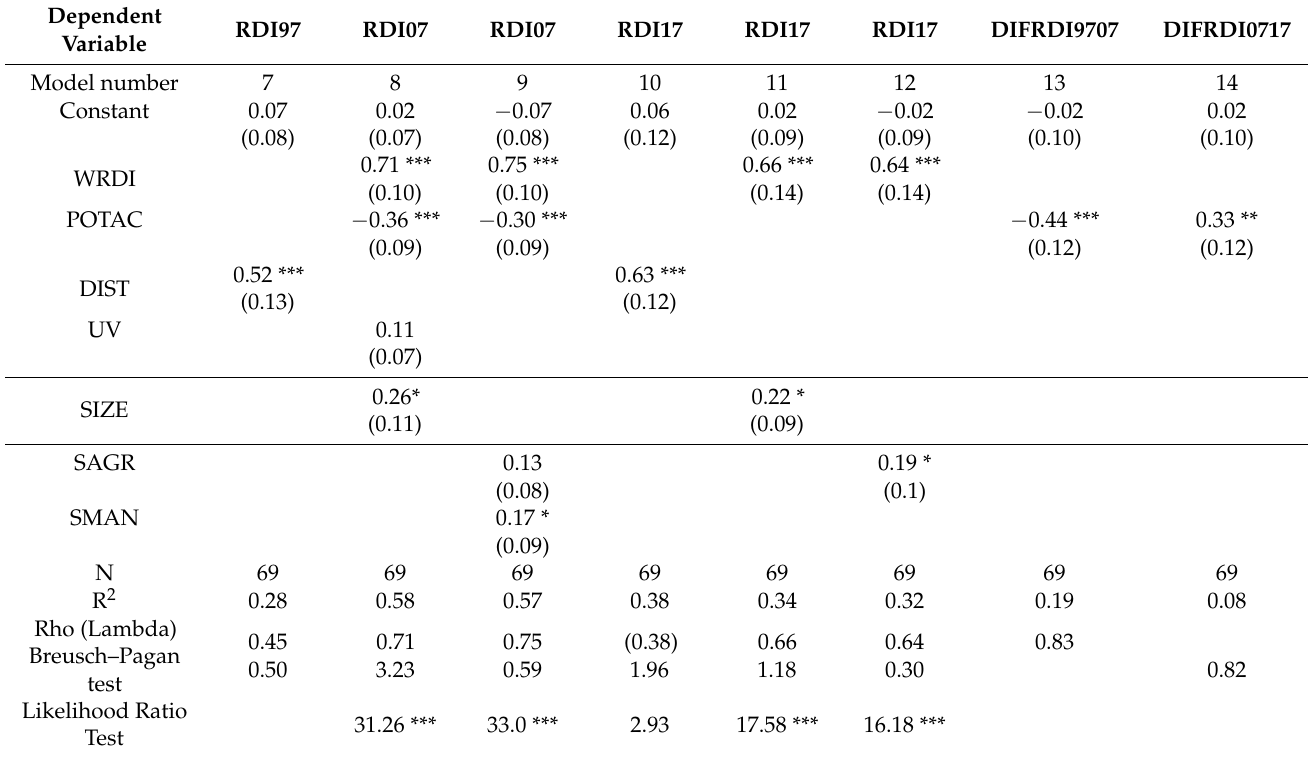
Table 4. Regression models with the RDI SK as the dependent